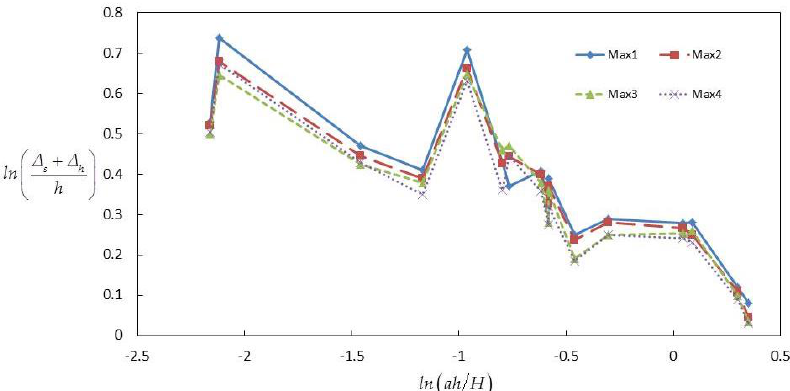
Figure 9. Height of the theoretical zero point Δ s varies with the comprehensive parameter ah/H . (calculated from original velocity data with different velocity integration in experiments of Dunn et al. [1]). Figure 10. Influence d epth Δ s + Δ h varies with the comprehensive parameter ah/H . (calculated from original velocity data with different velocity integration in experiments of Dunn et al. [1]).